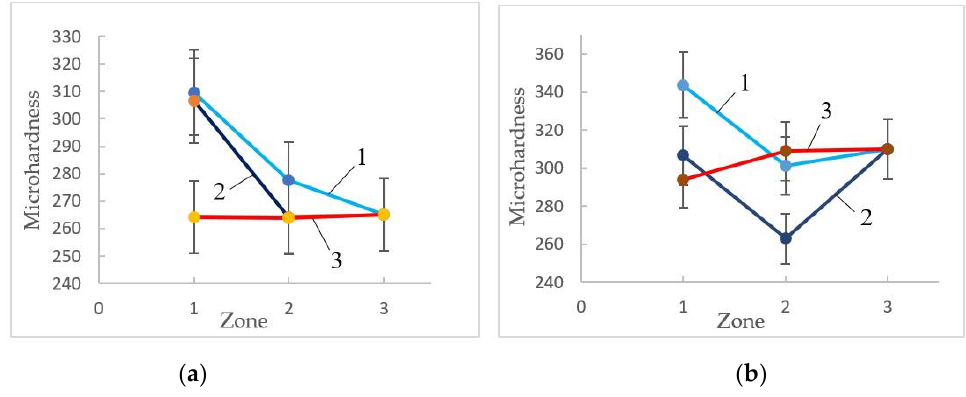
Figure 7. Changes in microhardness along the sample length in ( a ) CG and ( b ) UFG titanium de-